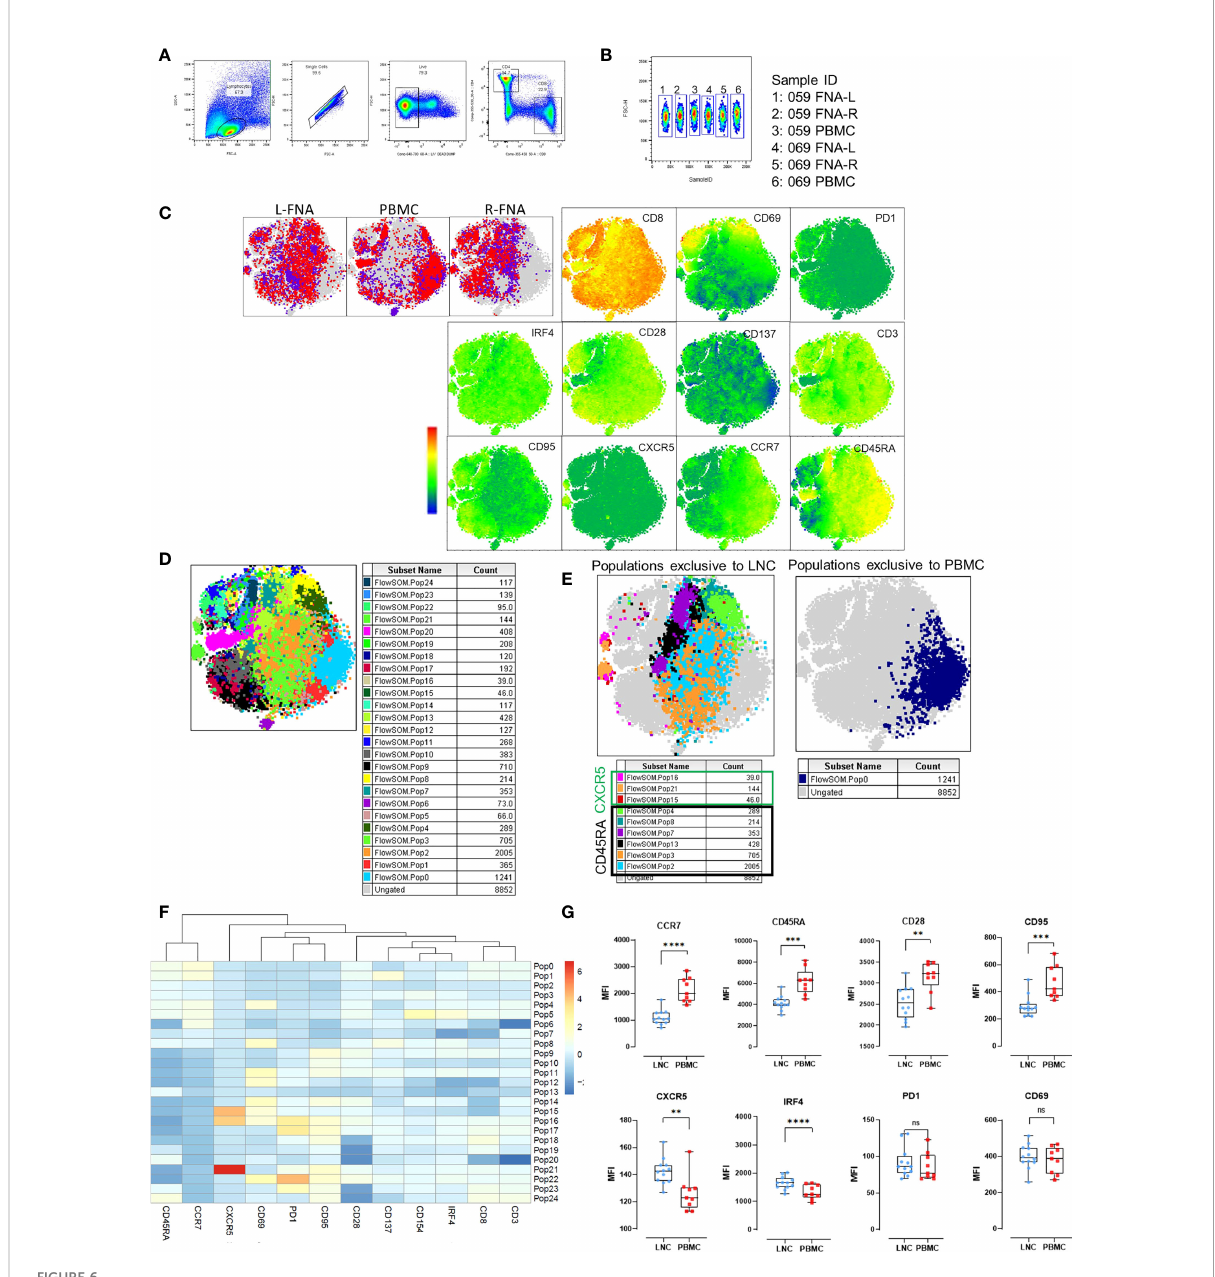
FIGURE 6 Phenotypic distinction of naïve-type CD8+ T cells in the lymph node compared with the blood. (A) Pairwise analysis of CD8+ T cells from down sampled data from LNC and PBMC (1531 events from each participant) was conducted (n=2) PBMC and LNC were cultured in media for 18 hours in the IRF4 assay. (B) Samples were identi fi ed using sample ID (C) t-SNE was run on these samples with perplexity of 30 Data were gated to identify the samples for L-FNA, PBMC and R-FNA using SampleID. Dots represent cells and color: purple and red represent the different participants and grey dots represent the ungated cells (cells that are absent in the gated subset). Expression of different markers is represented in the adjacent heatmap statistic plot. (D) 25 meta clusters detected by FlowSOM (E) Different subtypes of cells were identi fi ed by FlowSOM and plotted as subpopulations exclusive to LNC or PBMC using manual overlay. (F) Population heatmap showing relative expression of markers on the 25 metaclusters for FlowSOM populations are shown. (G) The median fl uorescence intensity of different markers expressed on CD8+ T naive cells were compared by means of two-dimensional analysis. (n=12 LNC left and right and n=9 PBMC). *p<0.05, **p<0.01, ***p<0.001,